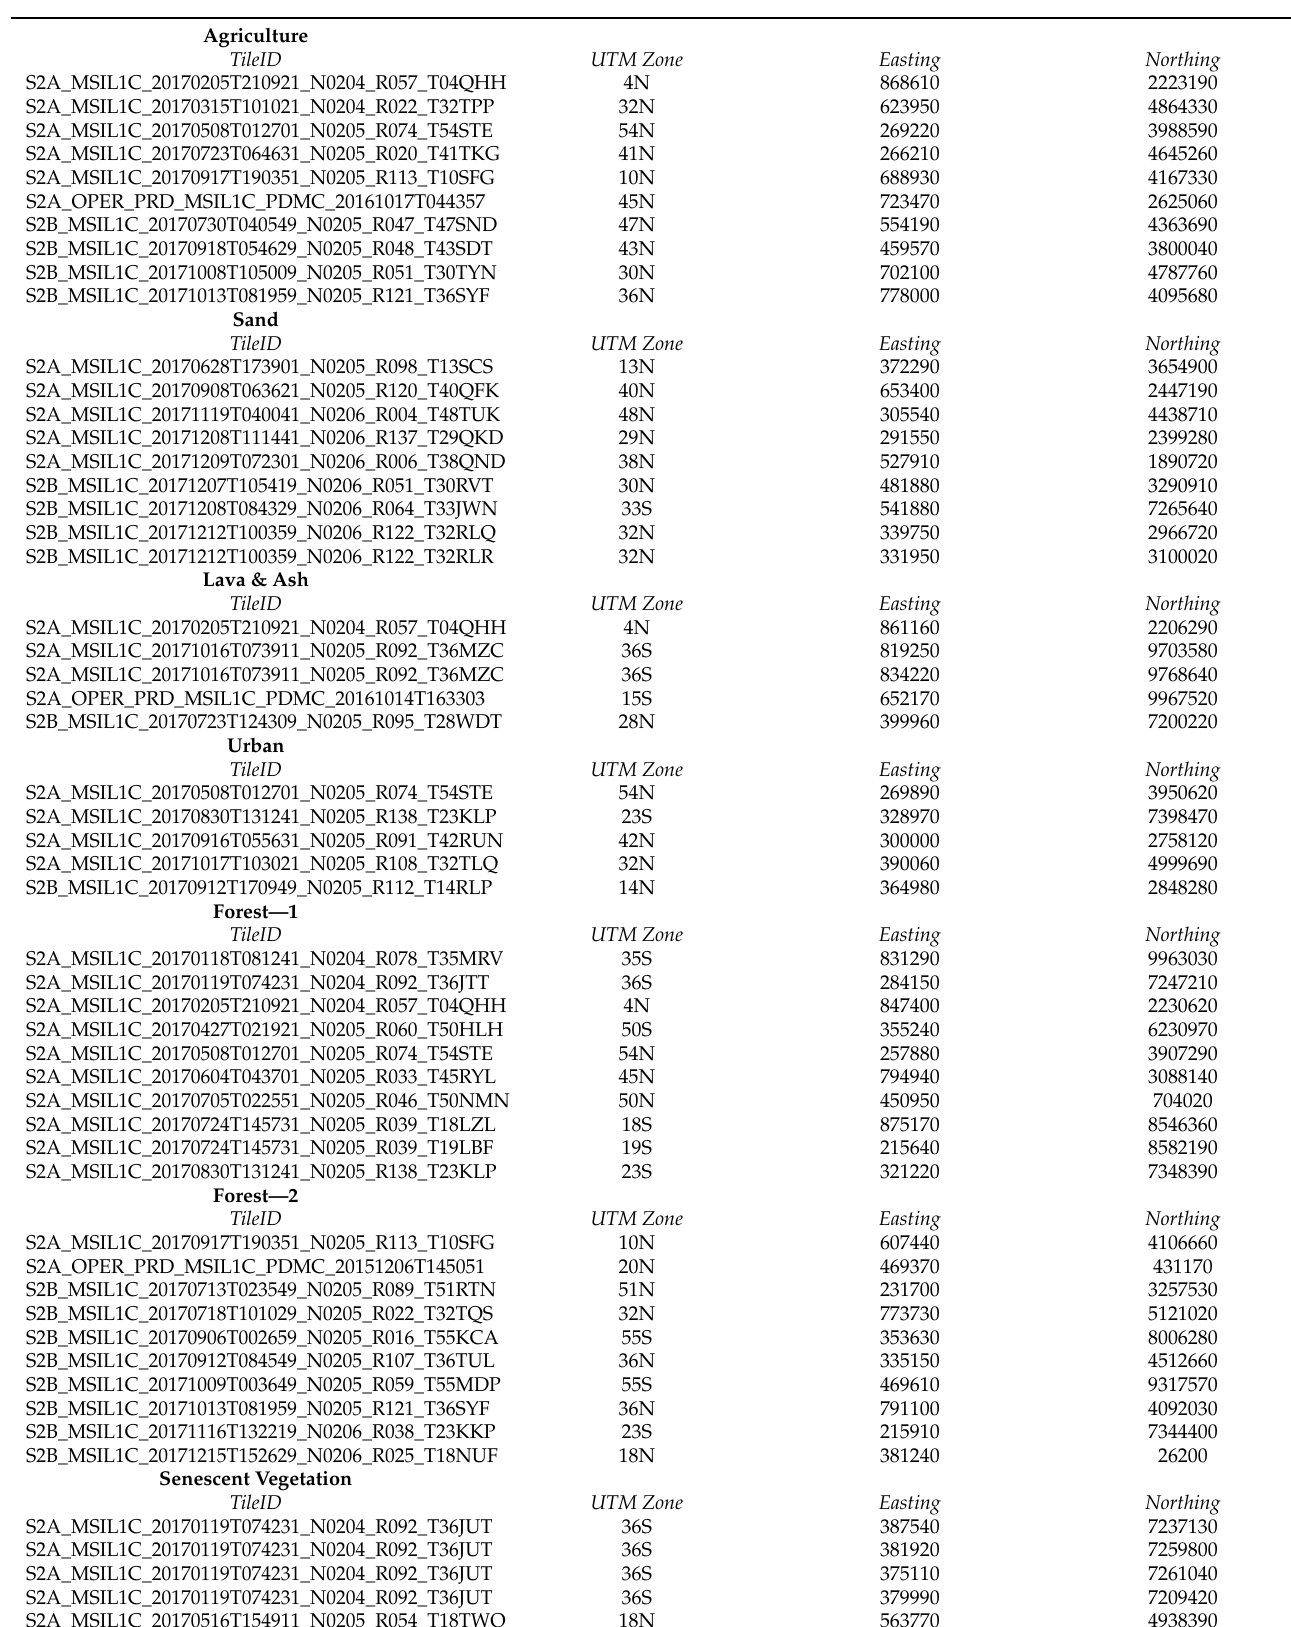
Table A2. TileIDs and NW corner coordinates of land cover subcategory